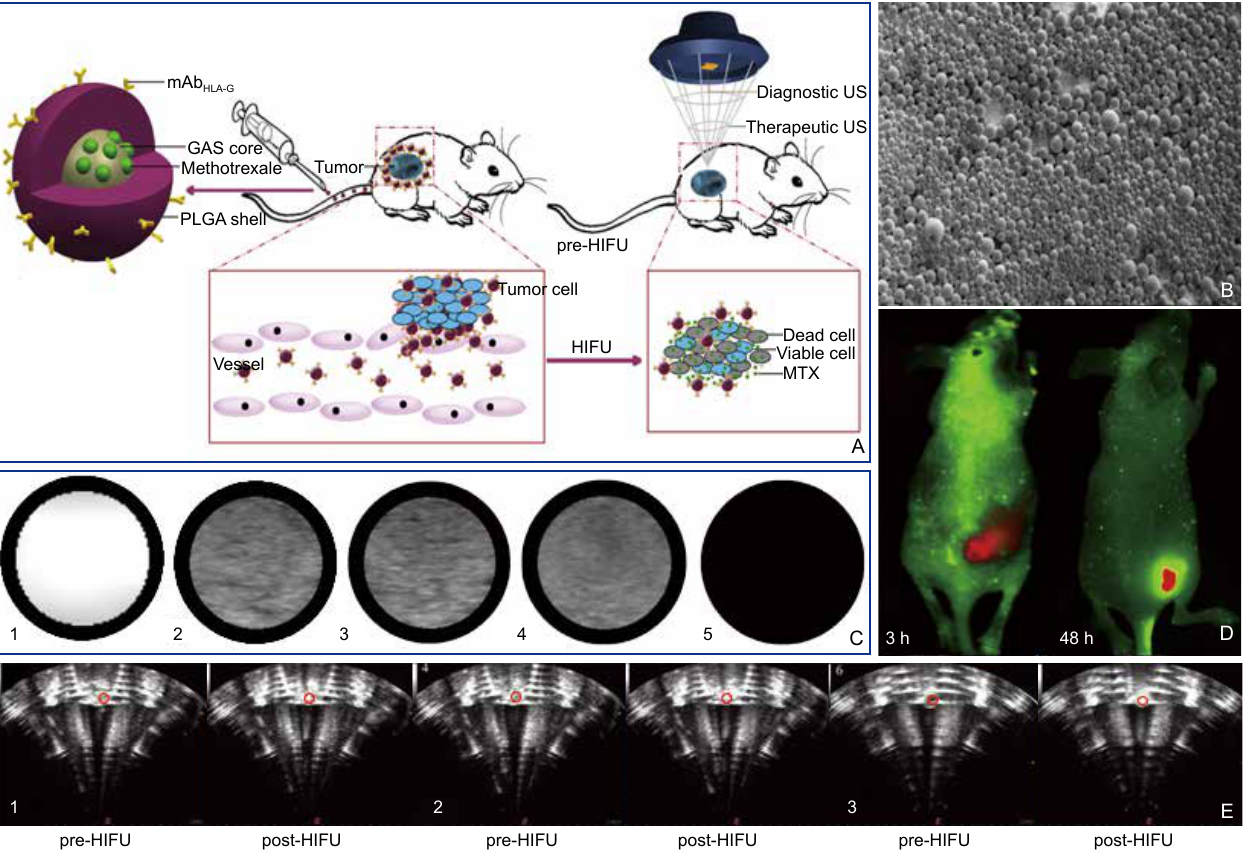
Figure 2 (A) Schematic illustration of the structure of mAb HLA-G /MTX/PLGA NBs and how mAb HLA-G /MTX/PLGA NBs act as a synergistic agent improving the treatment efficacy of HIFU ablation for tumor and residual tumor cells; (B) SEM image of mAb HLA-G /MTX/PLGA NBs with diameter of 477.6 ± 119.7 nm; (C) In vitro ultrasound images of the different samples: (1) air (control); (2) 200 mg/mL mAb HLA-G /MTX/PLGA NBs; (3) 200 mg/ mL pure PLGA NBs; (4) 200 mg/mL MTX/PLGA NBs; (5) de-gassed and deionized water (control); (D) 0.5 mL of DiI-labeled mAb HLA-G /MTX/PLGA NBs are injected via the tail vein, then in vivo imaging of JEG-3 cells in the back of choriocarcinoma subcutaneous transplant sarcoma model by DiI- labeled mAb HLA-G /MTX/PLGA NBs at 3 h and 48 h time point after injection. The results display the target ability of mAb HLA-G /MTX/PLGA NBs; (E) The diagnostic sensor of HIFU shows the echoes of targeted tissue in the subcutaneous transplant tumor before and after HIFU ablation: (E1) HIFU+saline; (E2) HIFU+MTX/PLGA NBs; (E3) HIFU+mAb HLA-G /MTX/PLGA NBs. The results indicate that the acoustic signal of tumor tissues in mAb HLA-G -targeted NBs group was significantly higher than those in the saline control group and the non-targeted groups. (Reproduced with permission from